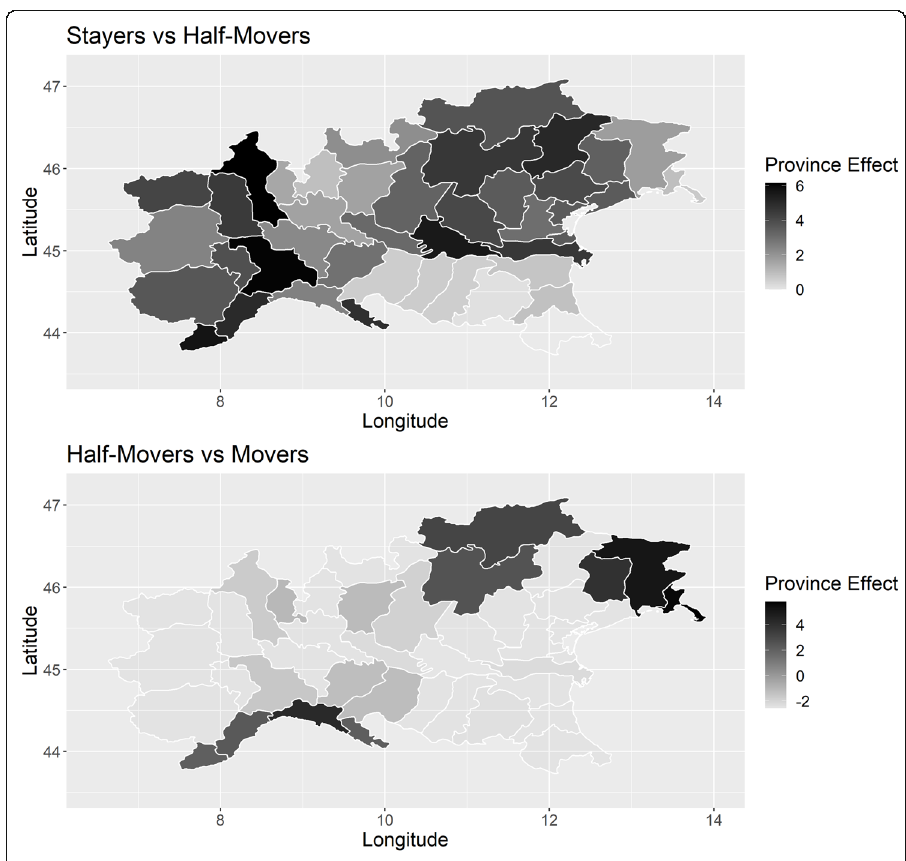
Fig. 5 Estimated effects of the province of residence on mobility, transparent colour for the base category (Province of Bologna), and provinces with no significant